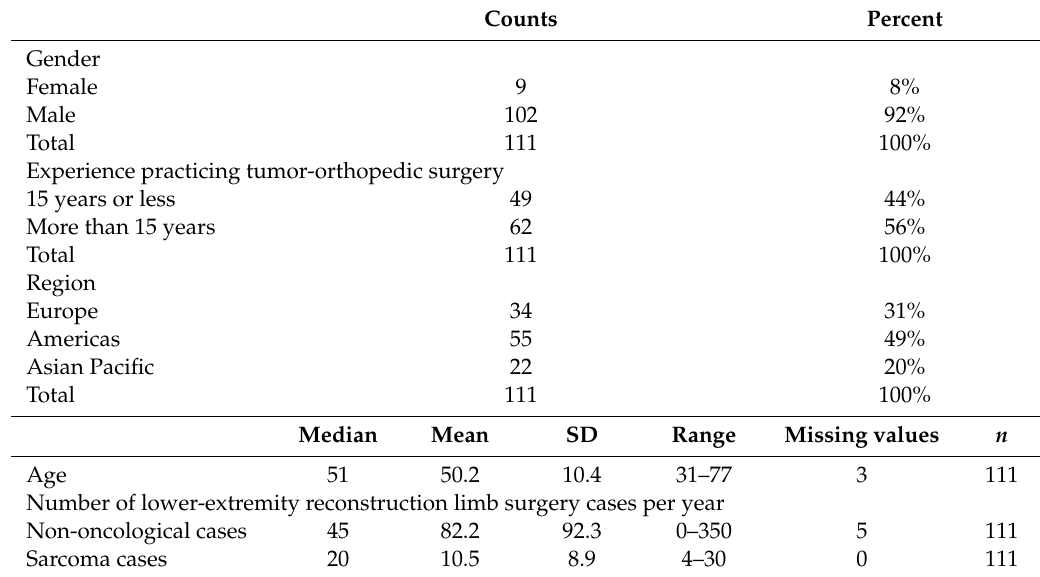
Table 2. Sociodemographic characteristics of the